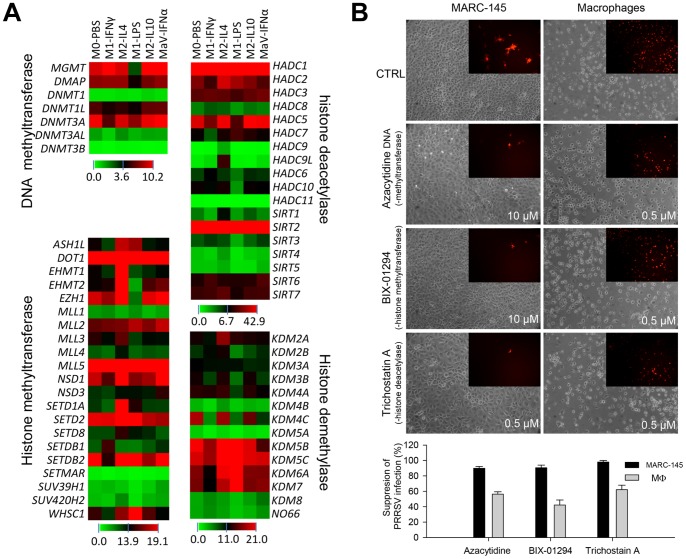
Epigenetic mechanisms for antiviral regulation.(A) RNA-Seq analysis of DEGs encoding key enzymes in epigenetic regulation. The heatmaps display family-wide collections of genes encoding DNA/histone methyltransferases, histone deacetylases and histone demethylases. In addition to differential expression analysis, these data also revealed family-wide transcription evidence of most of these porcine epigenetic genes at the mRNA level for the first time. (B) Suppression of PRRSV infection by epigenetic inhibitors at optimized concentrations in MARC-145 cells and porcine MФs. The fluorescent micrographs (inset) show infected cells using a DsRed-labeled PRRSV, whereas the larger bright-field images show cell phenotypes of non-visible cytotoxic effects. The micrographs represent one of three replicates. Summary data are presented below the images.